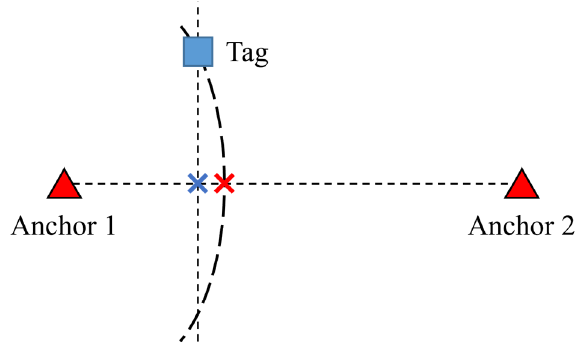
Figure 27. Cause of 1D bias.